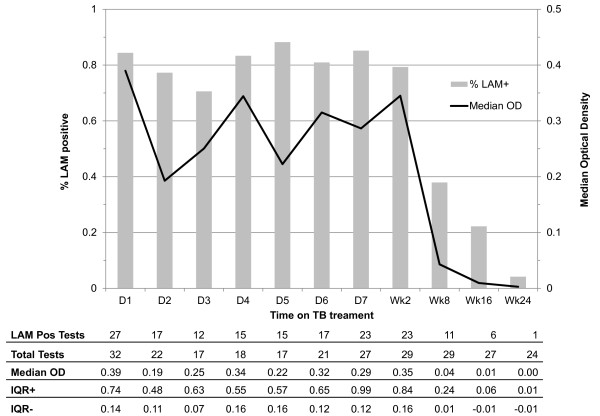
Proportion of LAM positive patients testing LAM positive at days 1-7, week 2, week 8, week 16 and week 24 and median LAM-ELISA optical density at each time point. Proportions are represented as bars (values shown on left-hand vertical axis) and median optical density is represented as a solid line (values shown on right-hand vertical axis). The number of patients who tested at each time point, median OD and IQR are shown in corresponding table below the figure